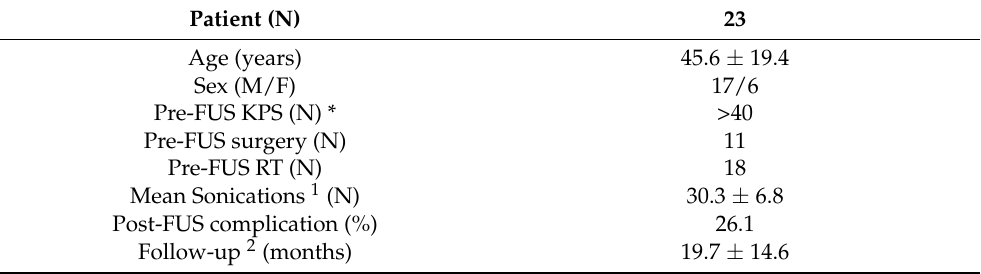
Table 2. Demographic and pre- and post-FUS session summary data of FUS-tumor ablation